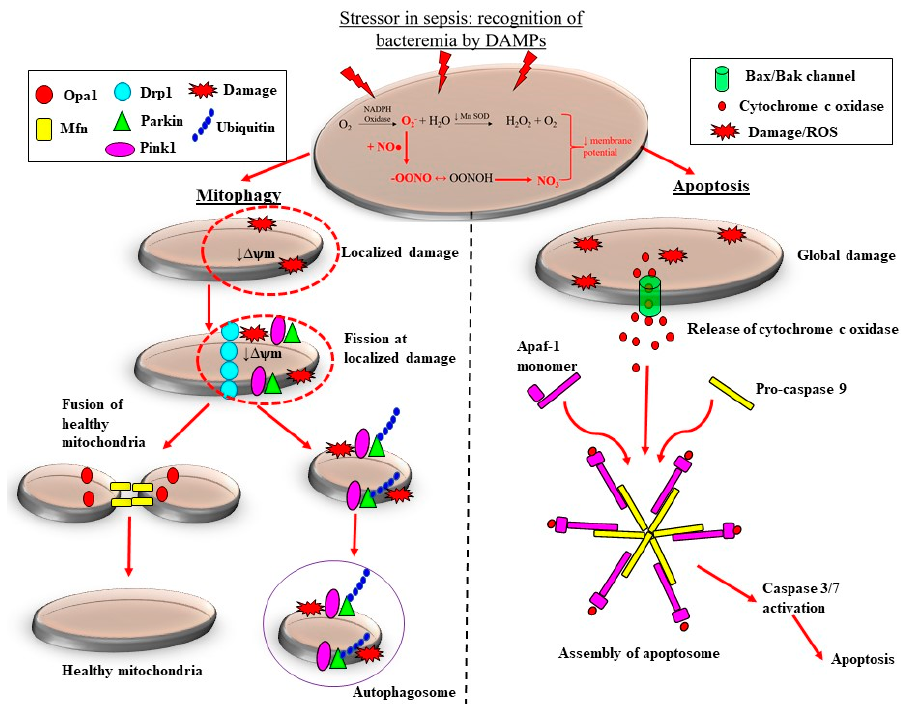
Figure 3. Adaptive and maladaptive responses of the mitochondria to sepsis-induced oxidative stress. Increased production of superoxide (O 2 − ) by nicotinamide adenine dinucleotide phosphate (NADPH) oxidase coupled with the reduced activity of manganese superoxide dismutase (MnSOD) results in the accumulation of O 2 − . Cytosolic nitric oxide (NO) produced by inducible nitric oxide synthase (iNOS) reacts with O 2 − , forming the highly reactive peroxynitrite (ONOO − ). The accumulation of O 2 − and ONOO − results in persistent oxidative stress and a reduction in mitochondrial membrane potential ( ψ m) and so mitochondrial dysfunction. In the case of localized mitochondrial damage, mitochondrial quality control mechanisms are activated which arrest mitochondrial dysfunction and limit excessive mitochondrial loss. Recruitment of mitochondrial fission proteins to sites of injury targets the damaged portions of the mitochondrion for fission. Subsequently, ubiquitin, PTEN- induced kinase (PINK1) and E3 ubiquitin-protein ligase (Parkin) proteins are recruited to the damaged mitochondrion, removed by mitochondrial fission and interact with phagophore, consequently forming an autophagosome. The healthy portion of the mitochondrion undergoes mitochondrial fusion, adding to the existing mitochondrial pool and limiting excessive mitochondrial loss. On the other hand, extensive damage to mitochondria in severe sepsis results in the release of cytochrome c oxidase, and in the formation of an apoptosome when it interacts with apoptotic protease activating factor-1 (Apaf-1) monomers and pro-caspase 9. This leads to downstream activation of caspase 3/7, ultimately resulting in the containment of sepsis-induced damage via apoptosis. Mitochondrial dynamin-like GTPase (OPA-1); dynamin related protein-1 (DRP-1); damage-associated molecular patterns